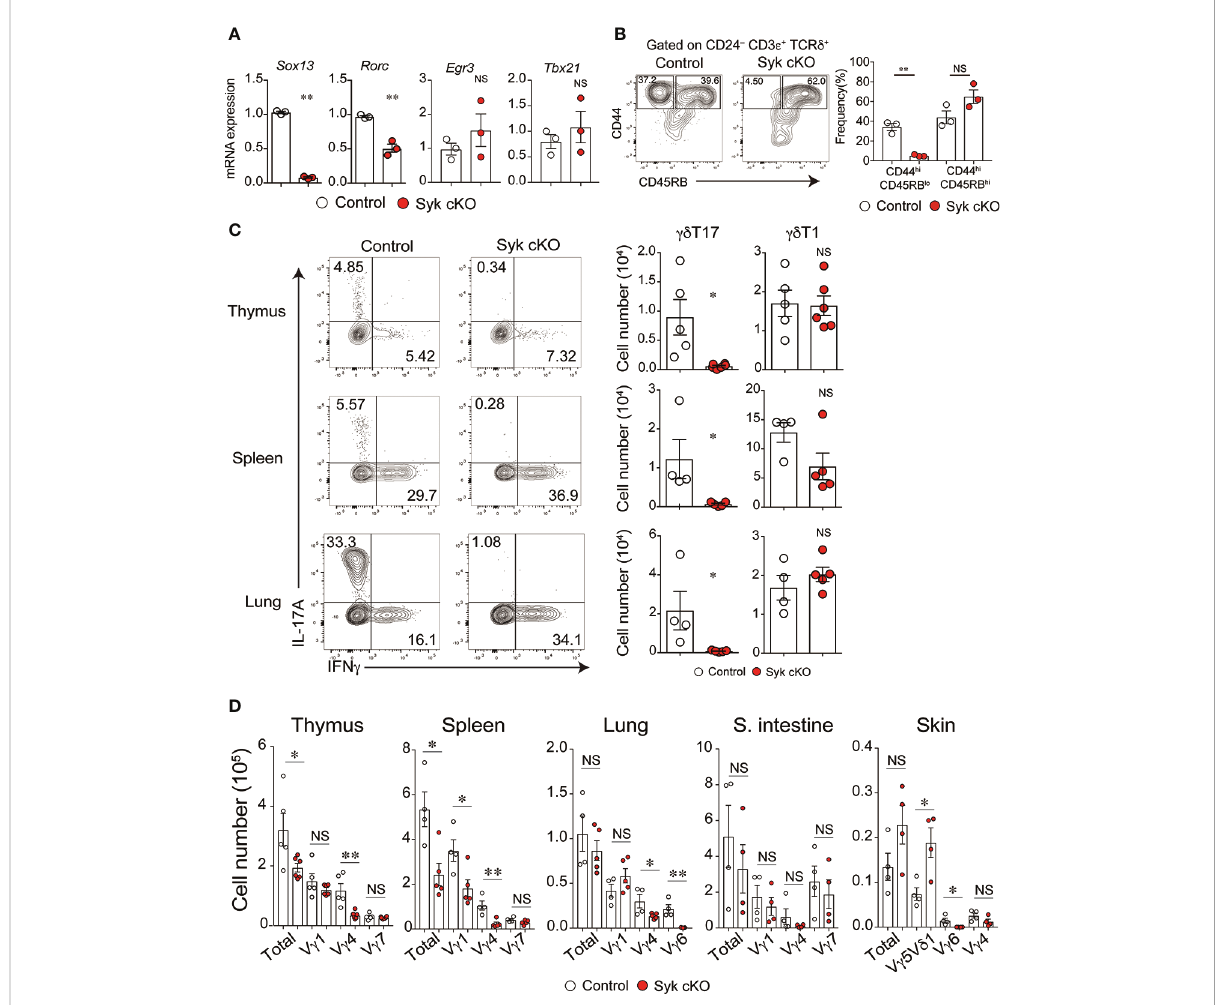
FIGURE 3 The impaired development of gd T17 cells but not gd T1 cells in Syk-cKO mice. (A) mRNA expression of Sox13 , Rorc , Egr3 and Tbx21 in thymic gd T cells from control (Cd127-cre Syk fl ox/wt, n = 3) or Syk-cKO mice (Cd127-cre Syk fl ox/ fl ox, n = 3). Gene expression was normalized to Gapdh . (B) Flow cytometric pro fi les of CD44 and CD45RB expression in CD24 lo gd T cells from thymuses of control or Syk-cKO mice. The graph indicates the frequency of the indicated gd T cell subset. (C) Intracellular staining for IL-17A and IFN g production in thymic, splenic and lung gd T cells from the indicated mice (n = 5 to 6). Cell staining was performed after a stimulation with PMA and ionomycin. The number of gd T17 and gd T1 cells is shown. (D) Graphs show the number of V g 1 + , V g 4 + , V g 5V d 1 + , V g 6 + and V g 7 + gd T cells as well as total gd T cells in the indicated tissues (n = 4 to 6). All data represent the mean ± SEM. In (B – D) , three independent experiments were performed. *P < 0.05 and **P < 0.01, by unpaired t-test. NS, not signi fi